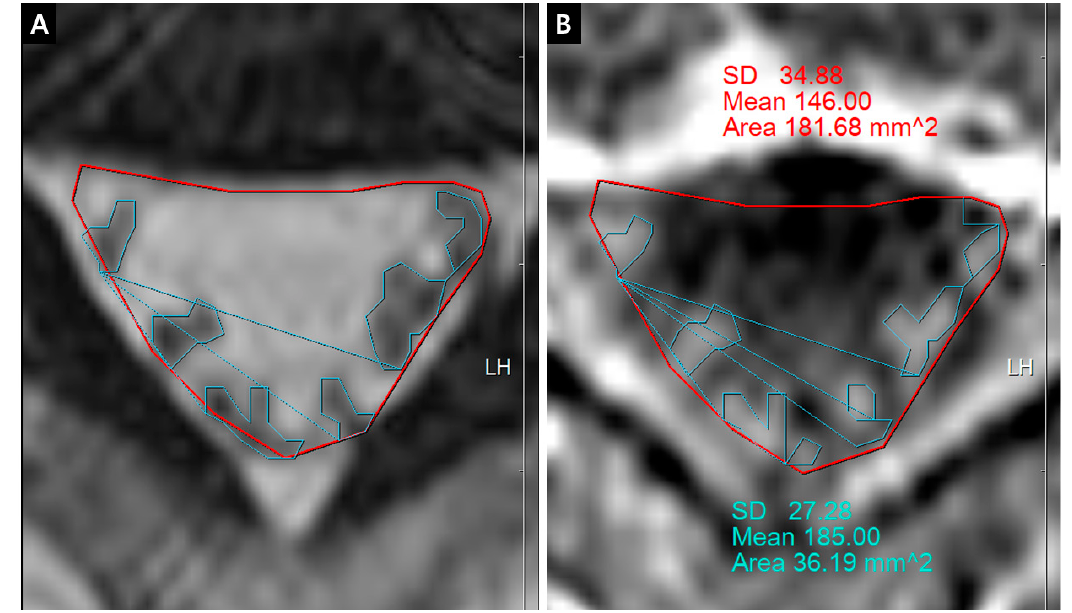
Figure 5. Whole rootlets IRCE (WR-IRCE) on L4–5 as a control. ( A ) T2-weighted axial image; ( B ) fat-suppressed enhanced T1-weighted axial image. SD—standard deviation